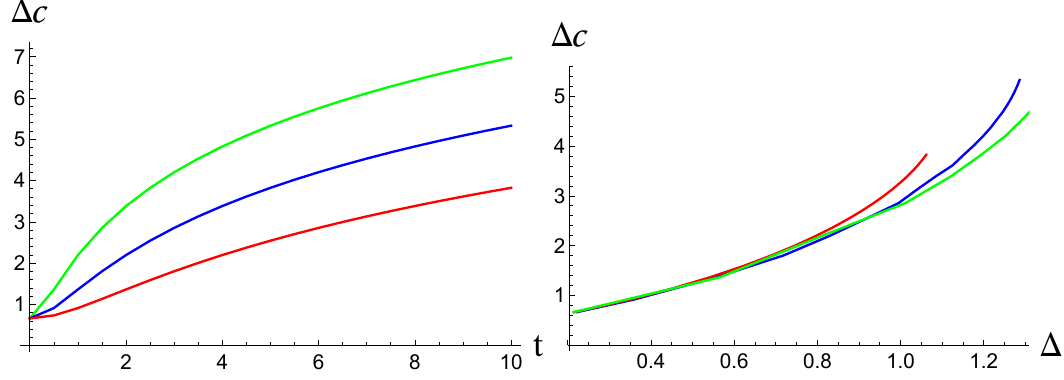
Figure 2 . On the left plot, we show the time dependence of the (rescaled) complexity (cid:1) C of the excitation. On the right plot, we present the dependence (cid:1) C ( t ) on (rescaled) (cid:1) S ( t ) as time changes from t = 0 to t = 10. The green curves correspond to (cid:11) = 0 : 25, the blue ones | to (cid:11) = 0 : 5, and the red ones | to (cid:11) =